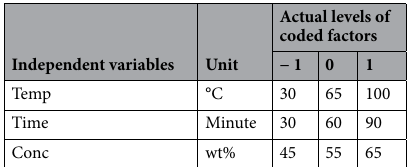
Table 1. Independent variables and levels for